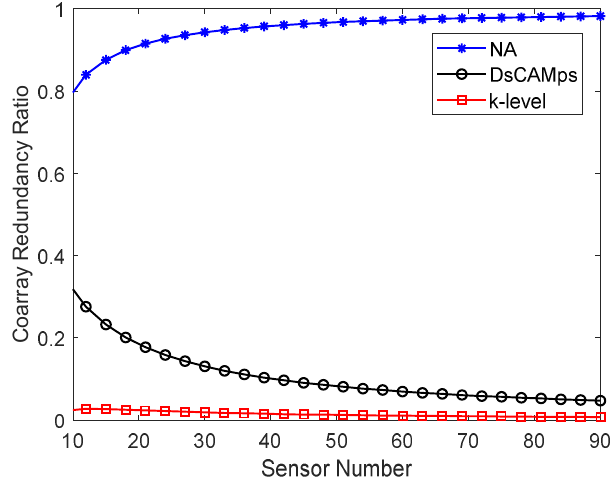
Figure 4. The comparisons of CARR.